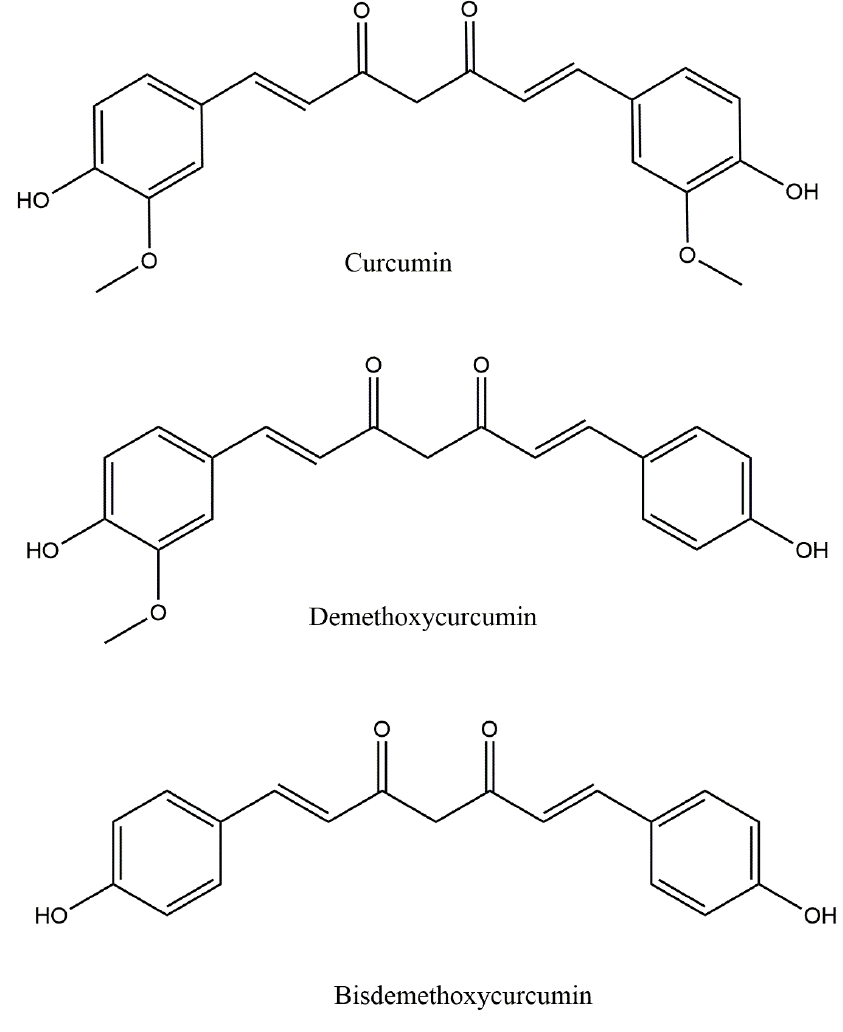
Figure 1. Chemical structures of curcuminoids.